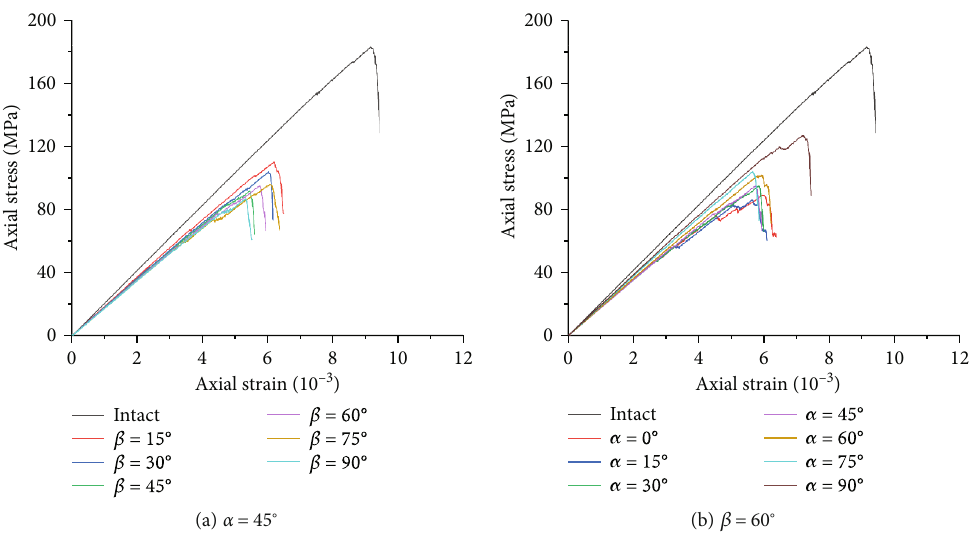
Figure 7: Stress-strain curves of numerical models. Table 3: Mechanical parameters of numerical